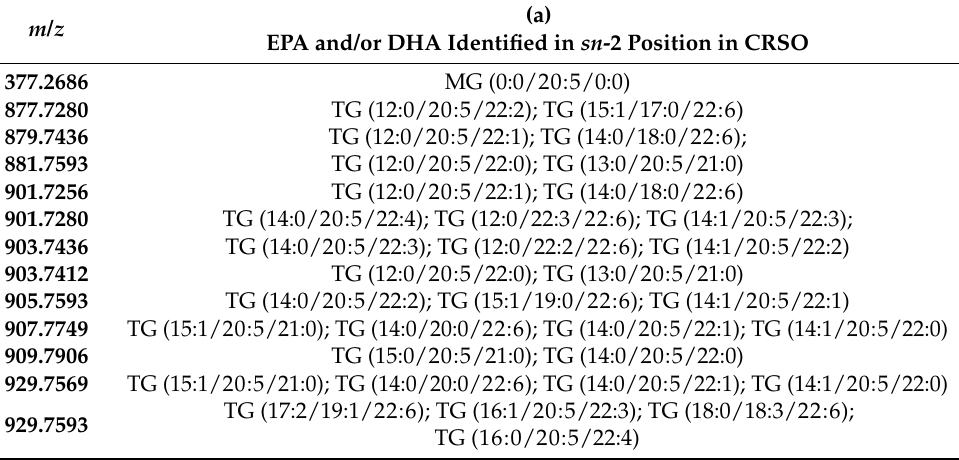
Table 4. Analysis of sn -2 position of EPA/DHA * in the monoacylglycerol (MG), diacylglycerol